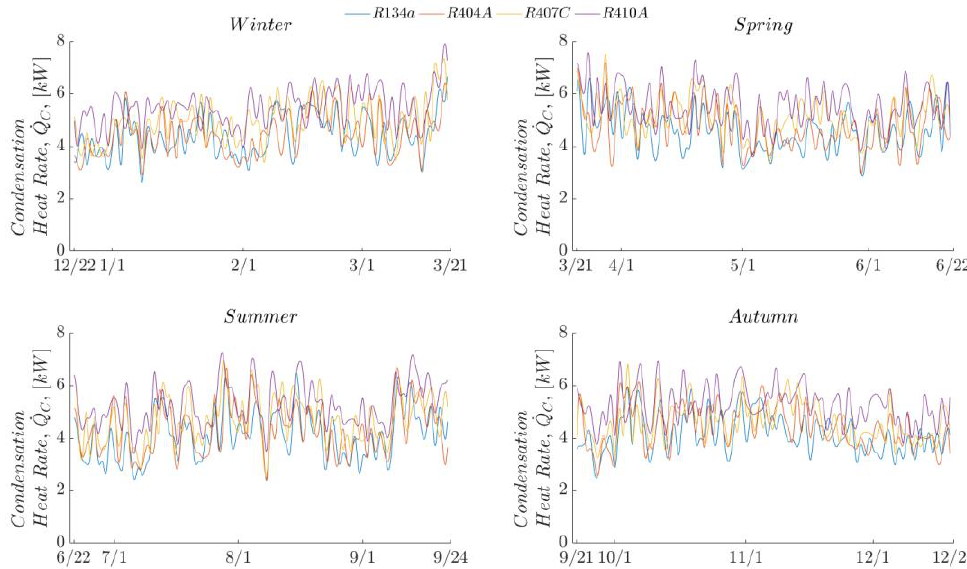
Figure 22. Seasonal condensation heat rate of the optimized system for all refrigerants.